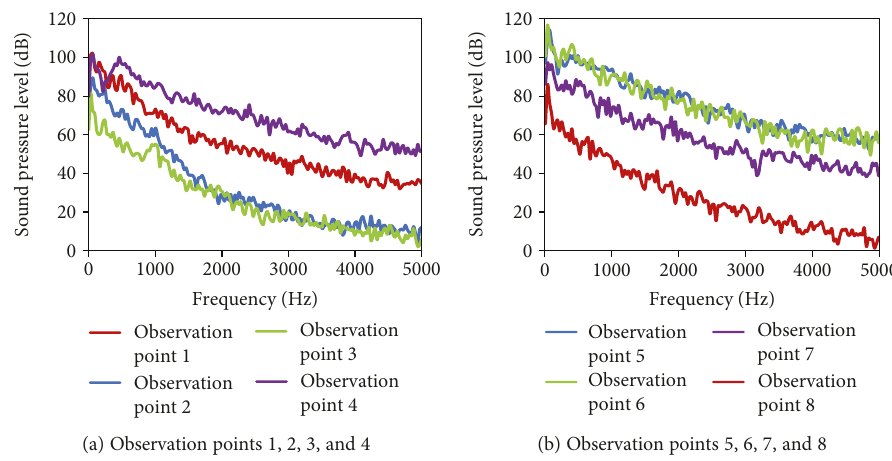
Figure 16: Sound pressure levels of observation points of improved